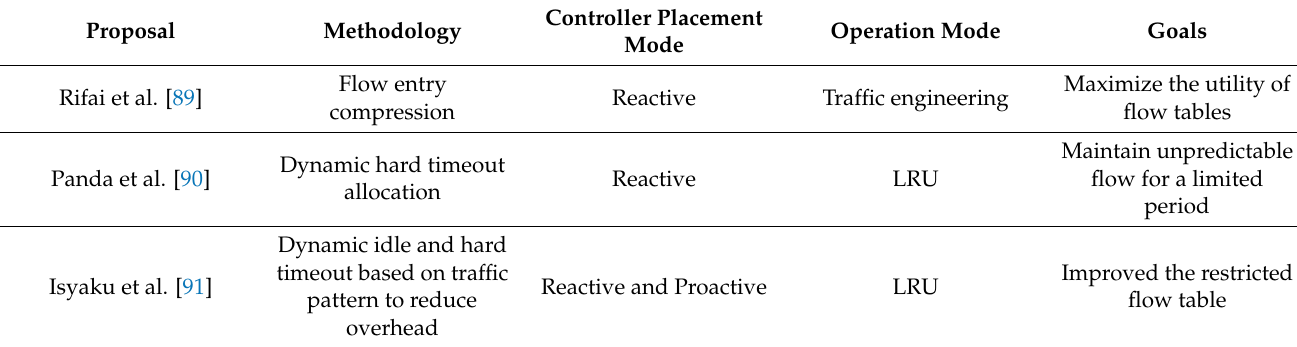
Table 5. Comparison of flow table management to improve OpenFlow